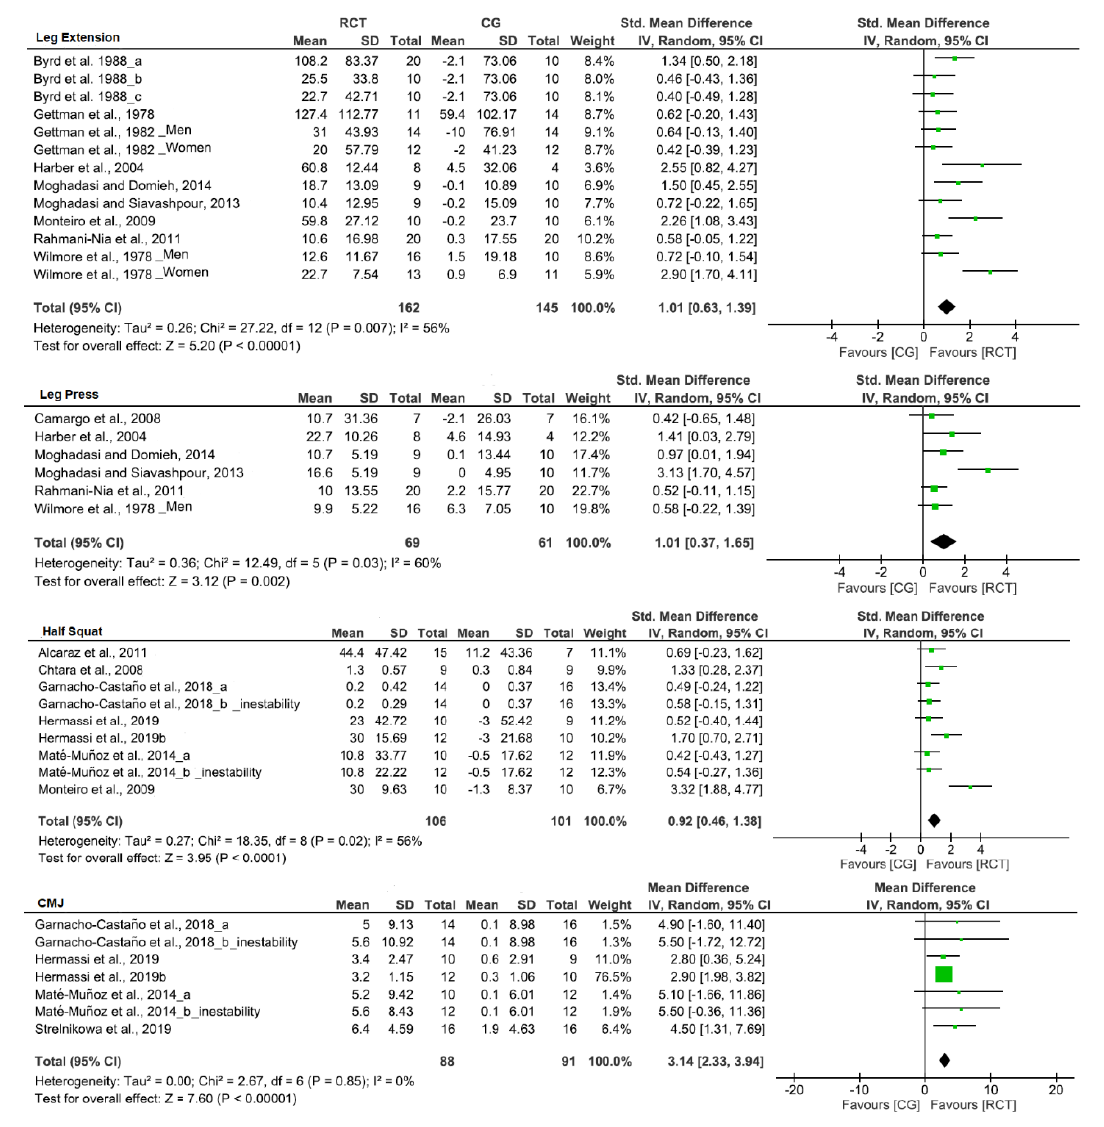
Figure 5. Forest plot showing the results of a random effects meta-analysis for resistance circuit training (CT) compared to control group (CG) on lower limbs exercise.